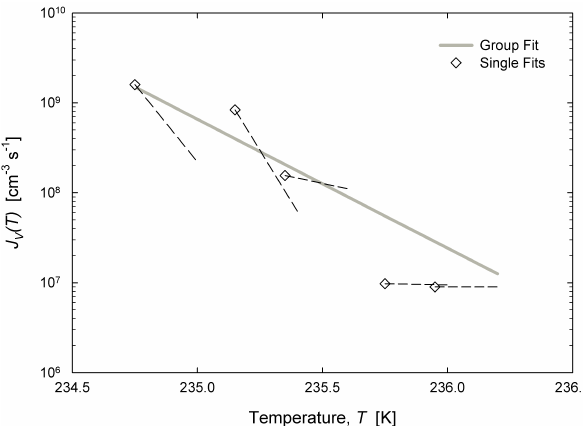
Fig. 10. Volume-based nucleation rate coefficients, J V , deter- mined from single and group fits to partially frozen experiments for medium droplets. The open diamonds indicate the lowest tem- perature reached in each freezing experiment, and the dashed lines show the temperature dependence of J V to 0.25K above the mini- mum